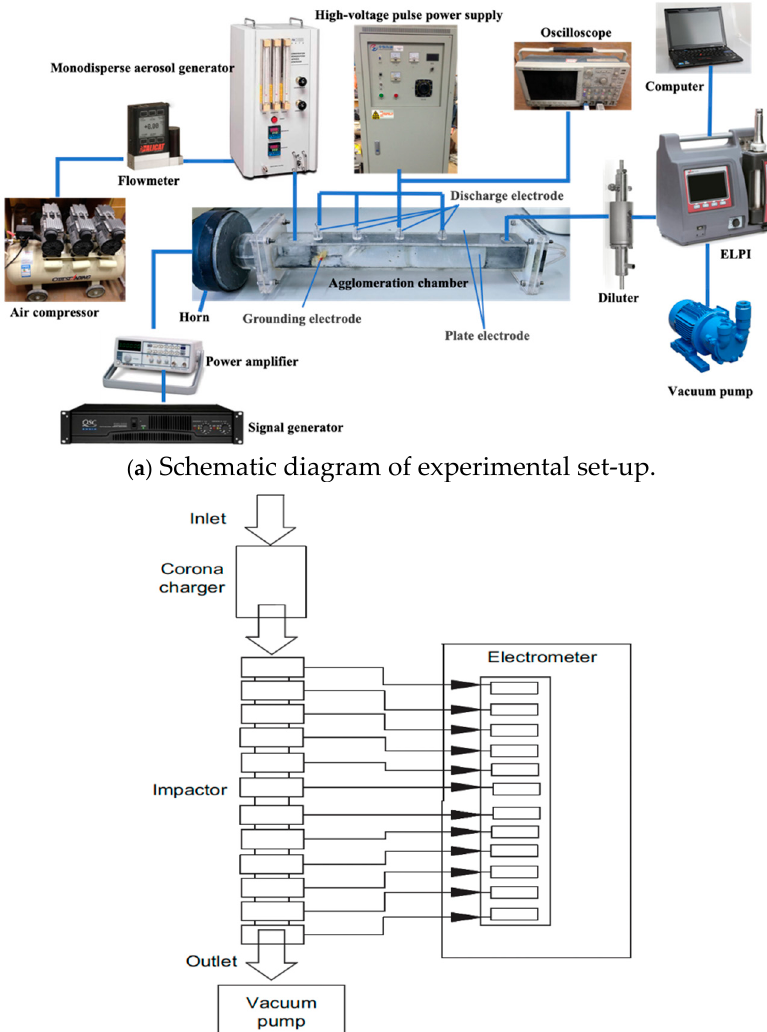
Figure 1. Schematic diagram of experimental set-up and electrical low-pressure impactor (ELPI).